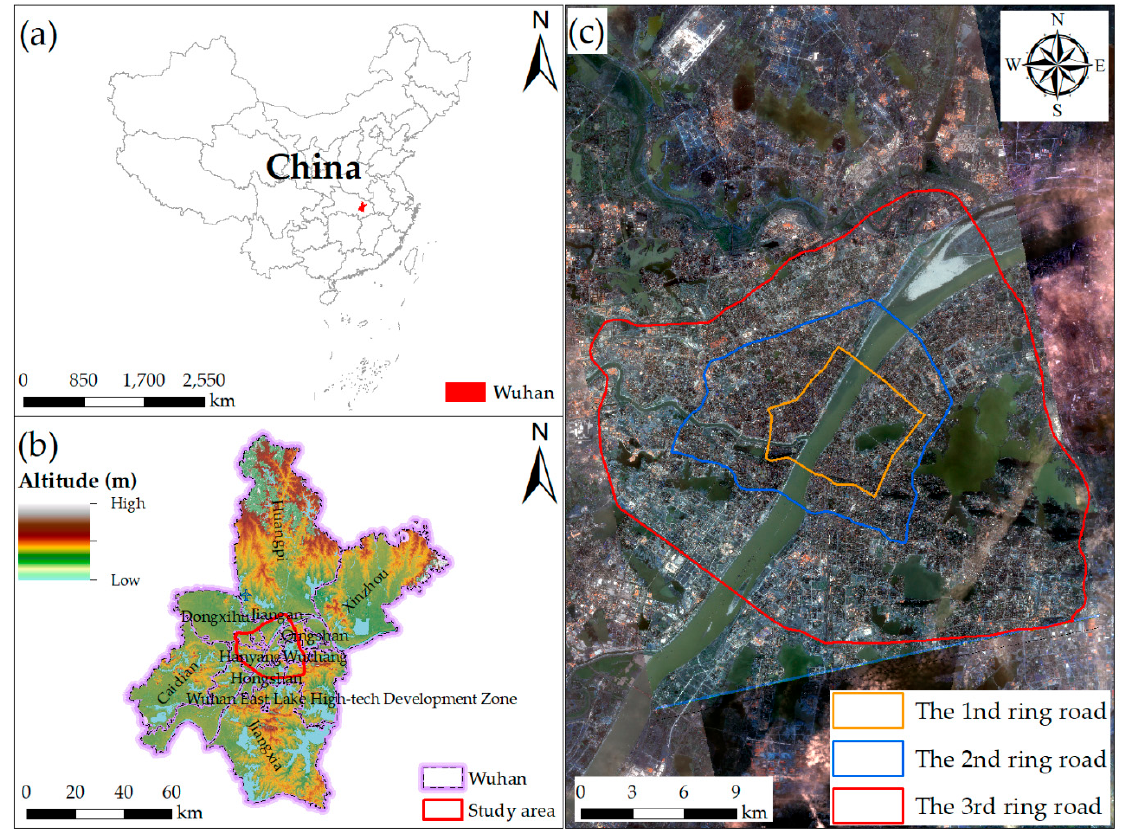
Figure 1. The geographic location of the study region in this study. ( a ) Geographic situation of study area; ( b ) regional situation of study area; ( c ) urban view of study area, showing the three ring roads of Wuhan, China.